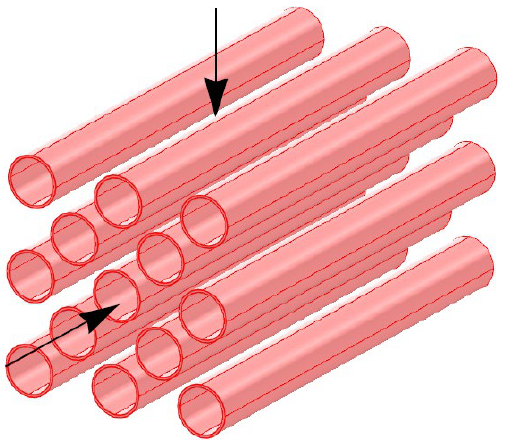
Figure 14. A staggered tube bundle from reboiler heat exchanger.